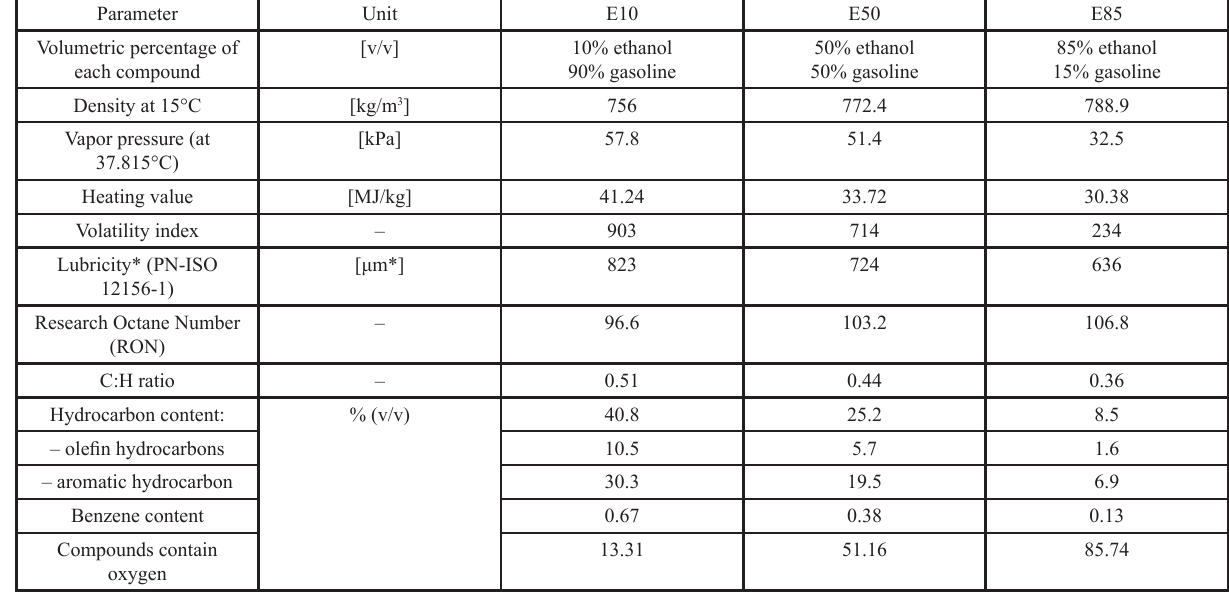
over the range E0–E20. x